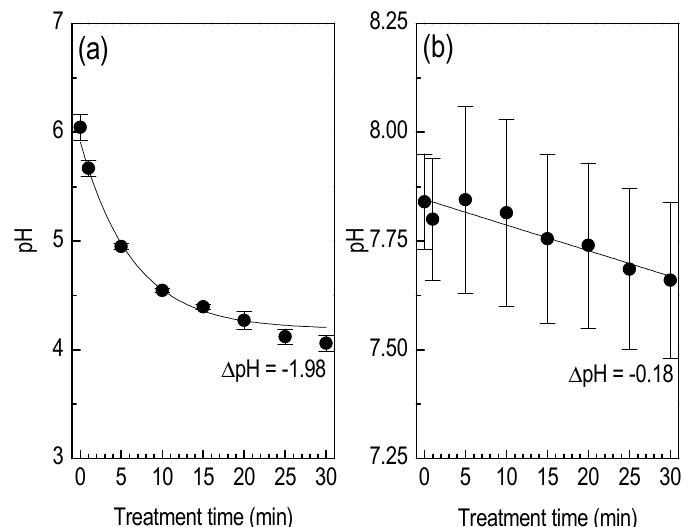
Figure 10. pH evolution versus the treatment time in the case of ( a ) DDW and ( b ) PBS. Mean values and standard deviations are calculated from two series of experiments carried out on different dates.